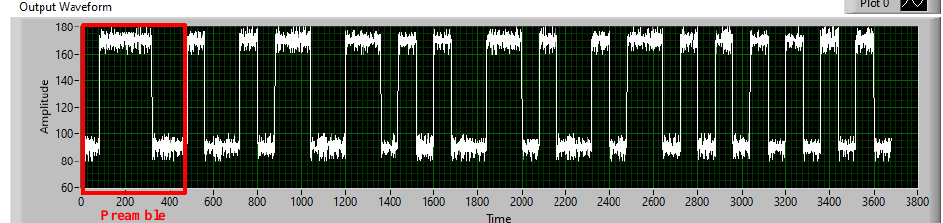
Figure 2. An experimental results of 2D-MIMO scheme from 48 LEDs (without 16 corner LEDs) in 8 × 8 matrix